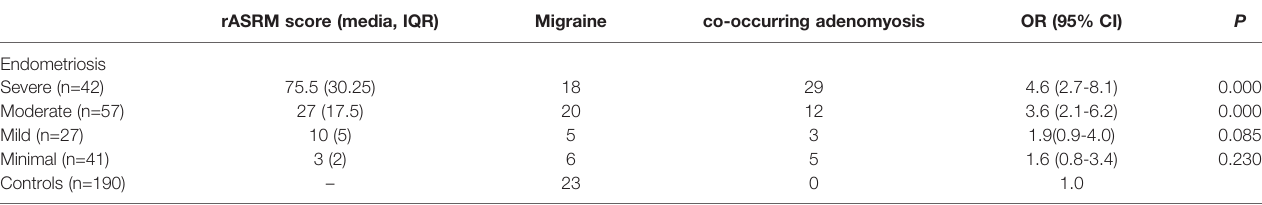
TABLE 3 | Odds ratio (OR) for four stages of endometriosis versus controls according to migraine*.